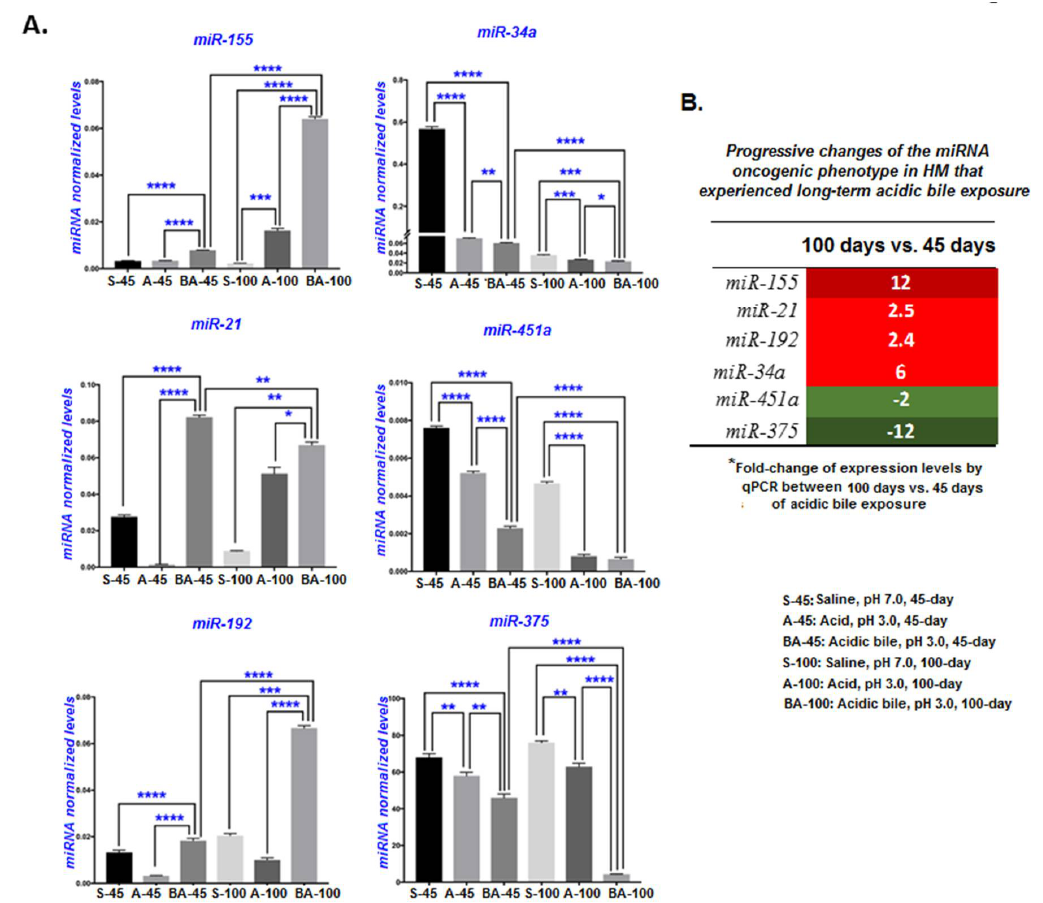
Figure 5. Progressive deregulation of the miRNA oncogenic phenotype. ( A ) Expression levels for each analyzed miRNA marker at 45 days and 100 days of exposure to saline (pH 7.0), acid alone (pH 3.0), and acidic bile (pH 3.0) (miRNA levels of each marker were normalized to RNU6 ; real-time qPCR analysis; Graph Pad Prism software 7.0). We observed a significant upregulation of “oncomirs” miR-21 , miR-155 , and miR-192 , and a significant downregulation of “tumor suppressors” miR-375 and miR-451a in HM exposed to acidic bile for 100 days vs. 45 days (* p < 0.01; ** p < 0.001; *** p < 0.0001; **** p < 0.00001; t -test; multiple comparisons using Holm–Sidak; GraphPad Prism 7.0; data obtained from four analyzed samples). ( B) Progressive changes of the miRNA oncogenic phenotype (fold-changes of miRNAs) in the HM expose to acidic bile for 100 days vs. 45 days.